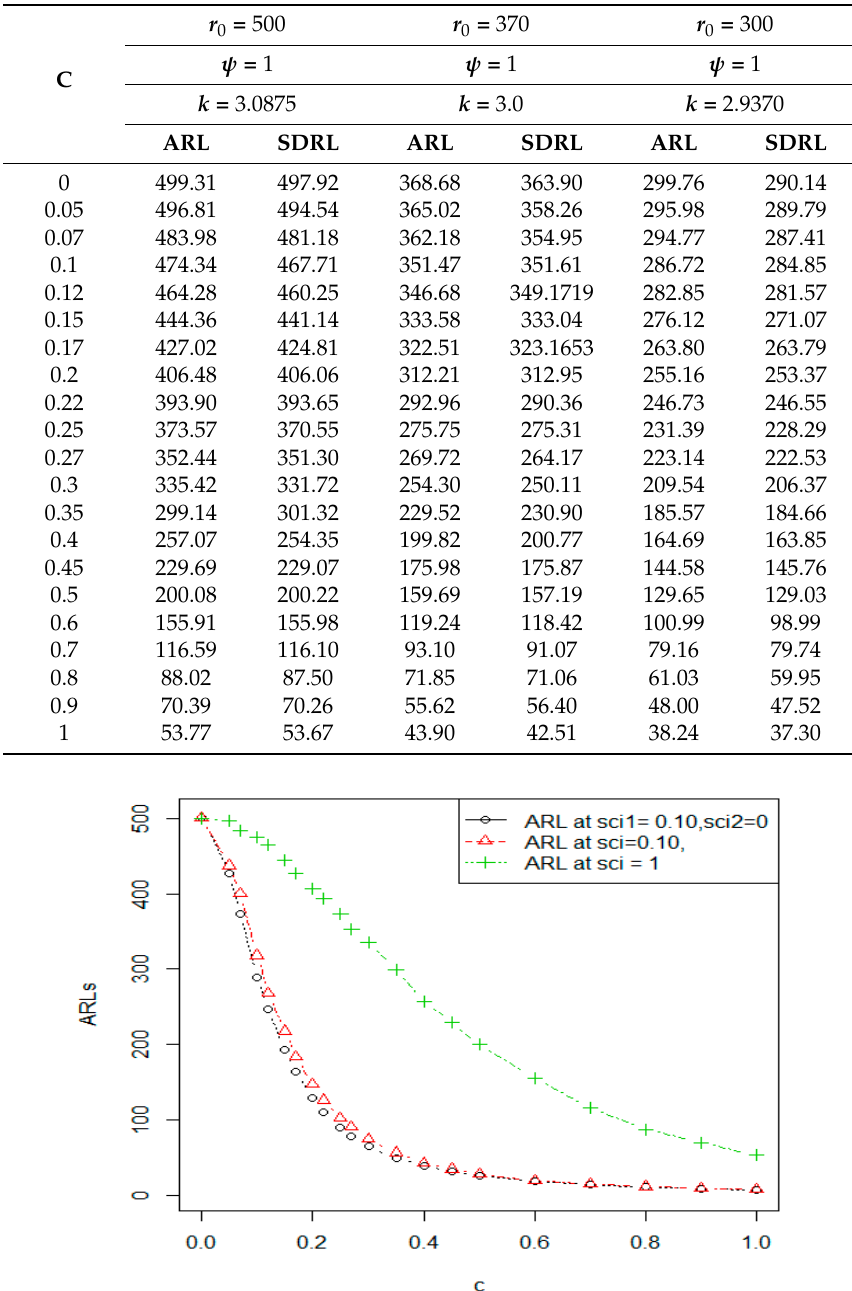
Figure 1. Graph of comparison of ARLs when 𝑟 (cid:2868) = 500 .